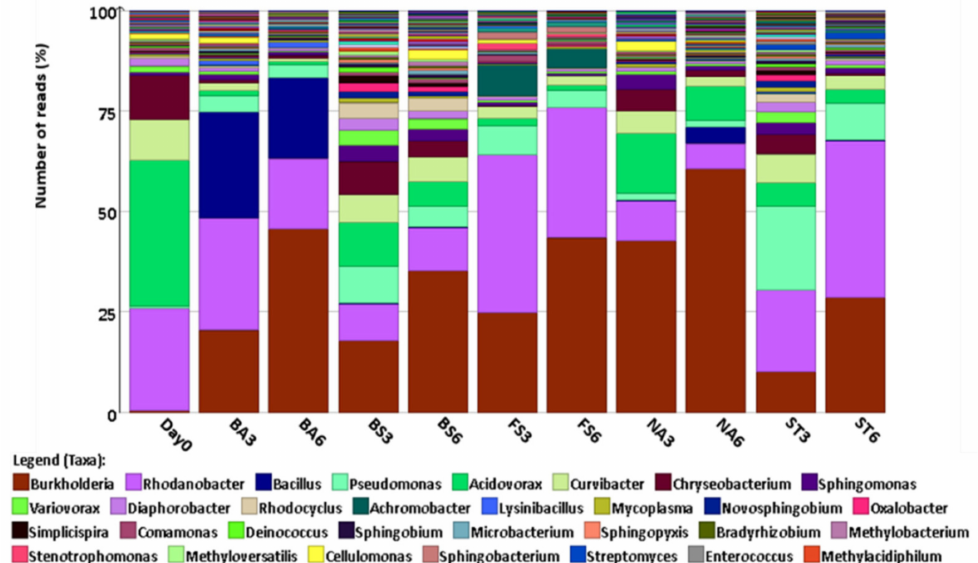
Figure 7. Bacterial diversity at genera level obtained from sequencing of 16S rDNA at week 6. NA: Natural attenuation; FS: Fusarium solani ; BS: Biostimulation; BA: Bacilli, ST: Streptomyces ; 3, 6: